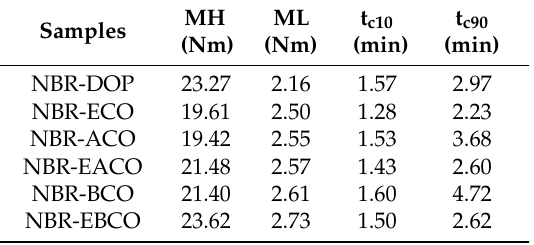
Table 2. Vulcanization characteristics data of di ff erent NBR